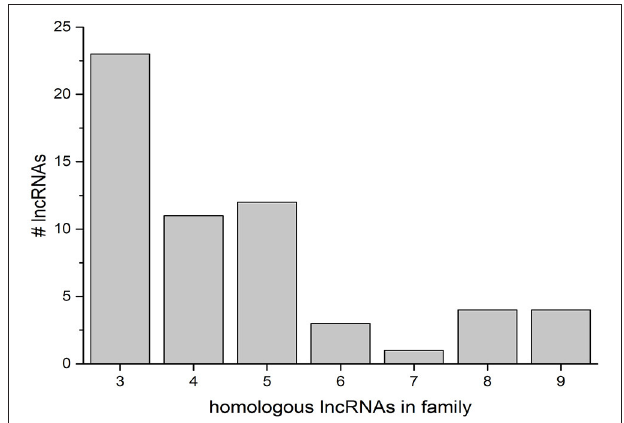
FIGURE 6 | Groups of homologous lncRNAs in the NCBI rice genome. Gene families were defined as three or more lncRNAs sharing significant matches of 100 bp or more. The number of searched lncRNAs that fall into a given gene family size is indicated on the